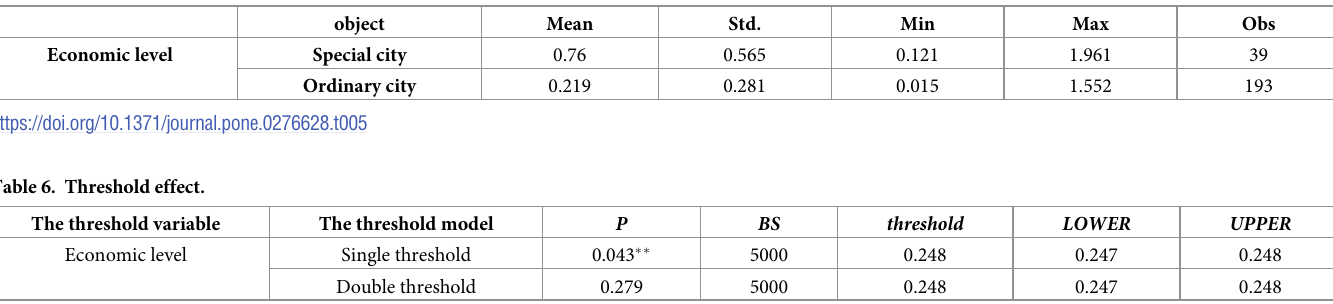
Table 5. Descriptive statistics of economic levels in different types of cities.